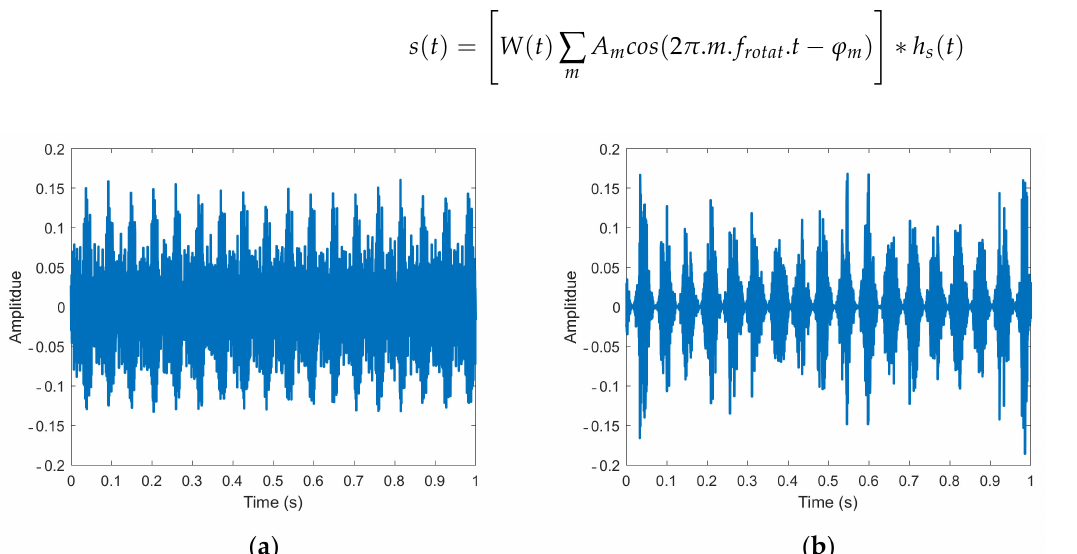
Figure 1. Cyclo-stationary signal model: ( a ) deterministic part and ( b ) stochastic part. Equations (8) and (9) are for the normal and defective signals composed of a combi- nation of Equations (6) and (7), respectively. Equation (8) assumes that the signal can be measured in normal rotating machinery without the defective signal. It is the sum of the deterministic part shown in Equation (6) and white noise w ( t ) . Equation (9) is the sum of the deterministic part d ( t ) , the stochastic part s ( t ) , and white noise w ( t ) , assuming that the signal occurs in faulty rotating